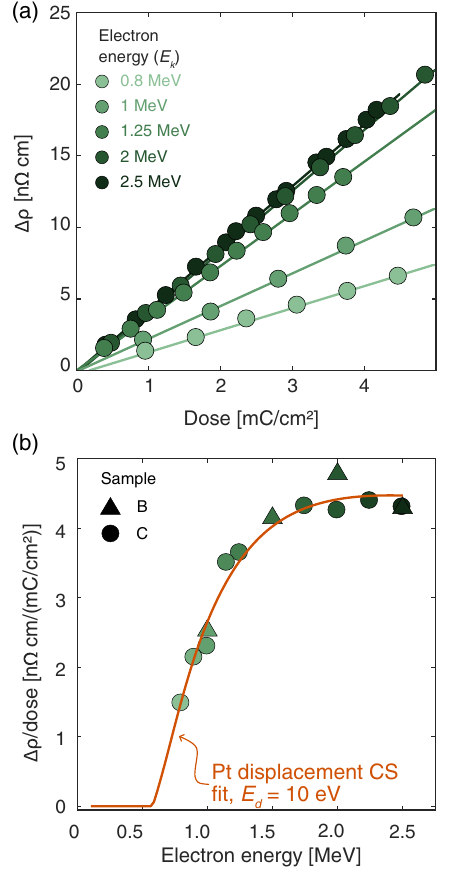
FIG. 8. (a) PtCoO 2 resistivity as a function of electron dose for a range of electron energies. (b) The rate of increase of the resistivity of PtCoO 2 as a function of electron energy, measured on two samples (symbols), compared to the calculated cross section (CS) for the displacement energy of 10